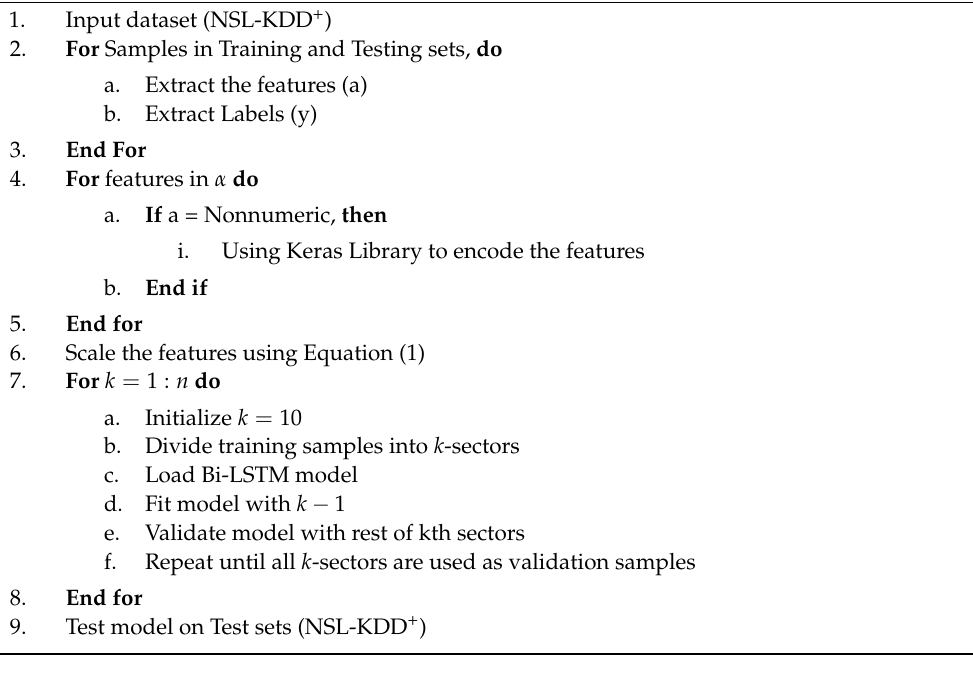
Algorithm 1: Training procedure for Bi-LSTM model